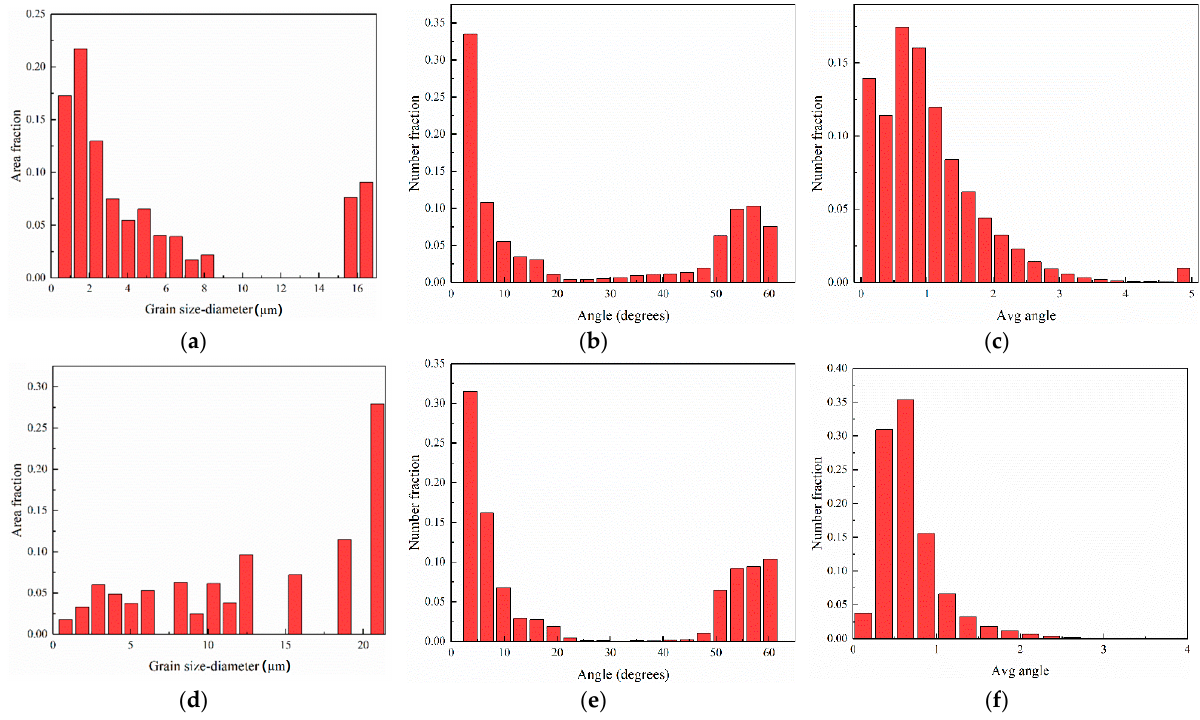
Figure 7. ( a , d ) Grain size, ( b , e ) size-angle grain boundary and ( c , f ) KAM distribution for ultra-low and conventional heat input,